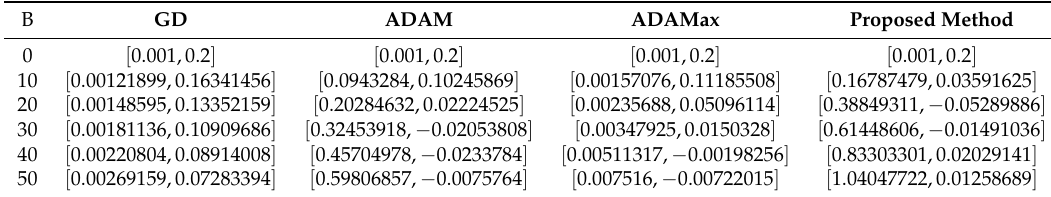
Figure 10. The results near the saddle point with an initial point of (0.001, 2). The iteration number is 50, the learning rate is 10 − 2 , and the β 1 , β 2 , and λ used in the proposed method are 0.95, 0.9999, and − 5 × 10 − 3 , respectively. Table 2. Change values of each